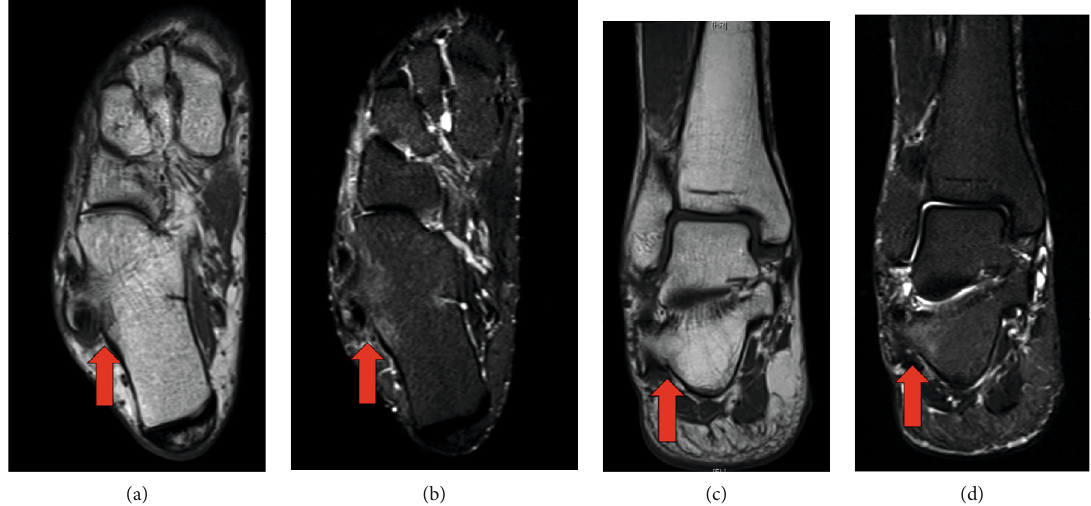
Figure 3: Right foot MRI: T1-weighted axial image (a), STIR axial image (b), T1-weighted coronal image (c), and STIR coronal image (d). Low-intensity lesion on T1-weighted image and high-intensity lesion on STIR image were detected around hypertrophic peroneal tubercle, and bone marrow lesions were suggested (red arrow).